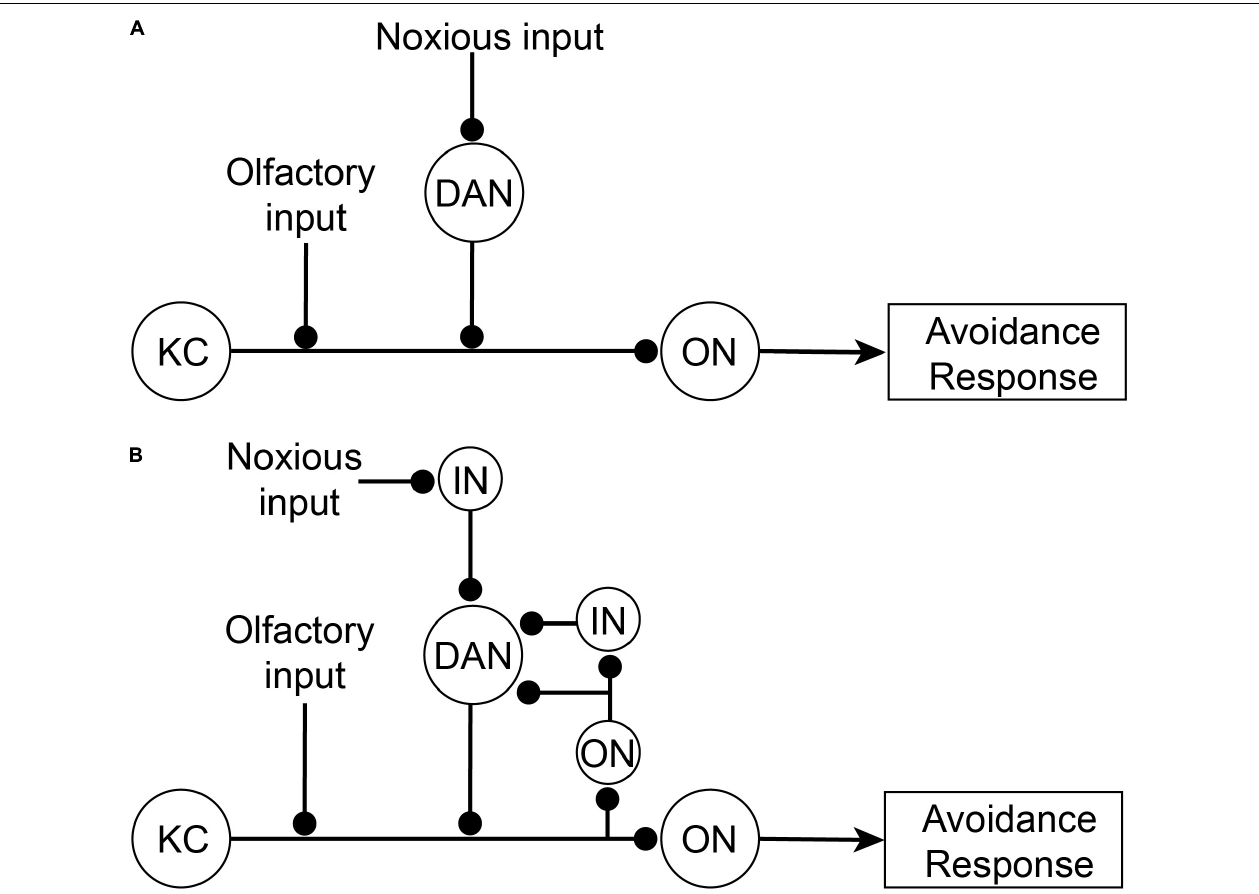
FIGURE 4 | Associative learning circuitry in the Mushroom Body of Drosophila . (A) Former simplified view of associative learning. The Kenyon Cell (KC) receives dual inputs both directly from olfactory projection neurons in the antennal lobe (see AL, Figure 5A ) from a neutral odor as the conditioned stimulus, and indirectly from noxious stimuli via dopaminergic neurons (DAN) in the posterior-lateral protocerebrum (see PLP, Figure 5A ). After learning the conditioned stimulus, tThe Kenyon Cells then activate Mushroom Body Output neurons (ON) which subsequently drive downstream avoidance response behaviors. (B) Updated circuitry responsible for associative learning. Recently it has been shown that DAN also receive feedback from output neurons (either directly or indirectly via interneurons; IN). DAN act as comparators that compare incoming noxious inputs with Kenyon Cell outputs (via ON) and produce a teaching signal. This teaching signal is used to strengthen olfactory inputs so that after learning olfactory inputs are sufficient, by themselves, to activate Kenyon